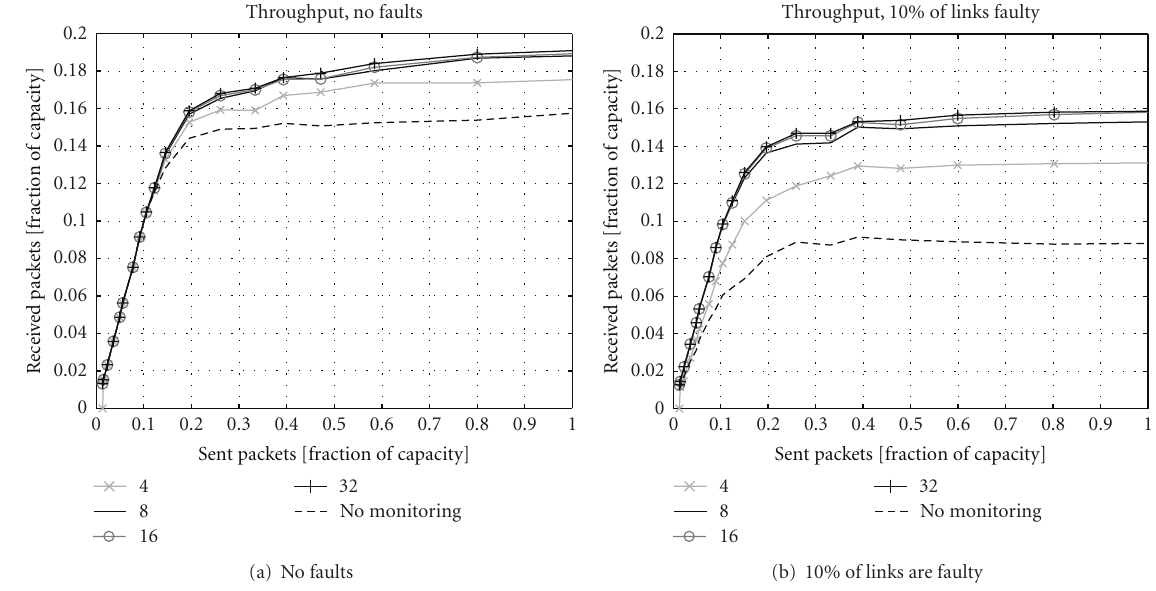
Figure 11: Throughput with di ff erent tra ffi c status granularity alternatives. C Size = 13 and data processing is